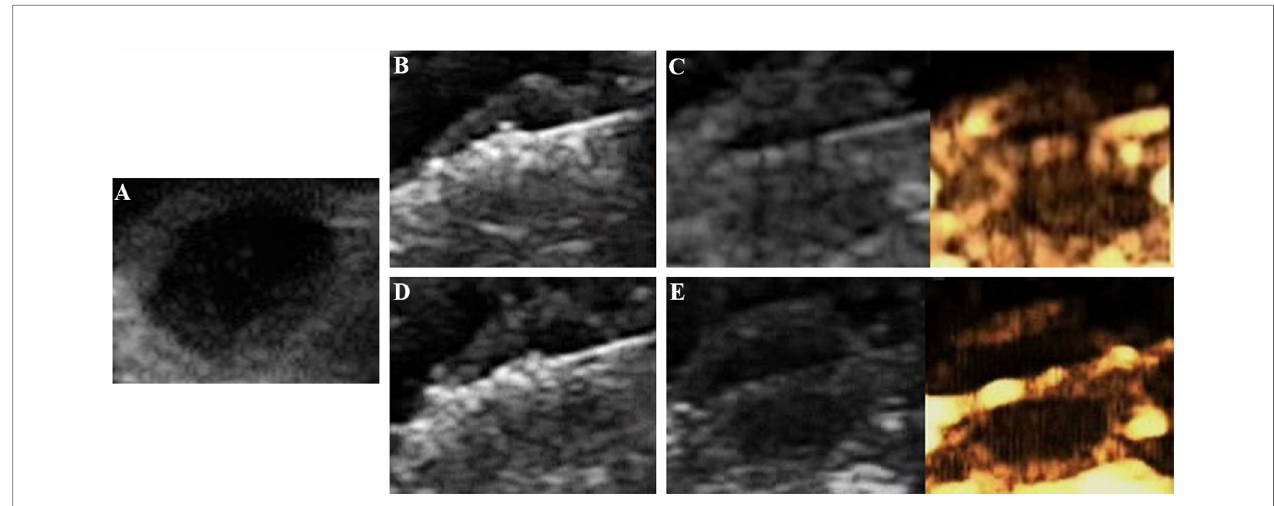
FIGURE 6 | Evaluation of the breast cancer (4T1) in nude mice by the targeted UCA after MWA: (A) before MWA, (B) hyperechoic region surrounding the antenna caused by vaporization, (C) contrast agent perfusion was observed in the periphery of the tumor after ablation. (A) complementary ablation: (D) a subsequent ablation procedure, (E) CEUS con fi rmed that the second ablation was